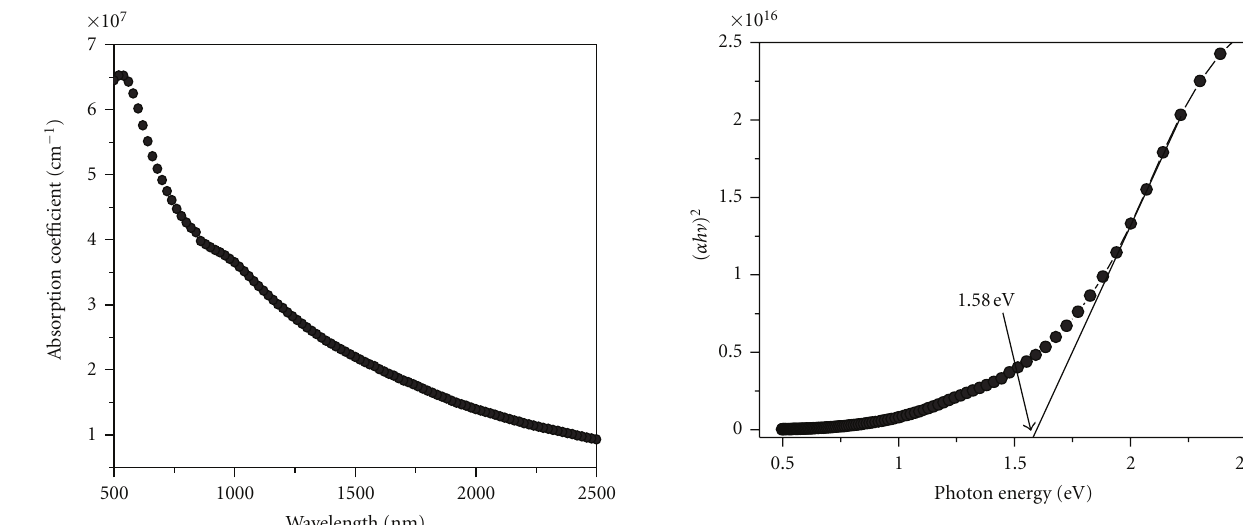
Figure 7: Tauc plot for determination of band gap.